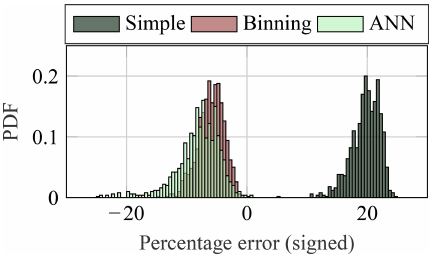
Figure 20. Empirical distribution for the (signed) percentage er- ror of predicted yearly damage using different extrapolation meth- ods. Prediction from a single year (1 October 2015 to 30 Septem- ber 2016) to another year (1 October 2016 to 30 September 2017). PDF: probability density function.